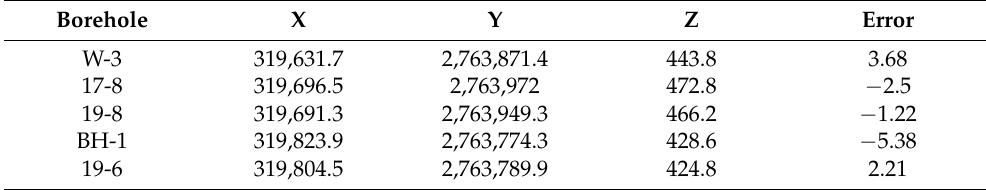
Table 2. Difference between actual and predicted data using first-order regression model in Zone 2. Borehole X Y